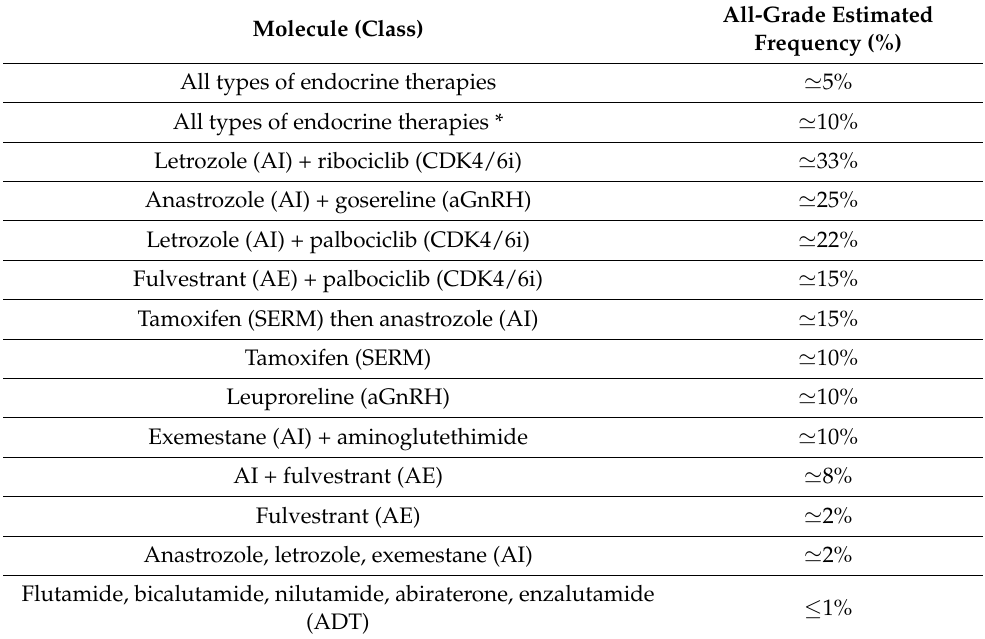
Table 5. Main endocrine therapies used against solid tumors and their corresponding frequency of alopecia (adapted from references